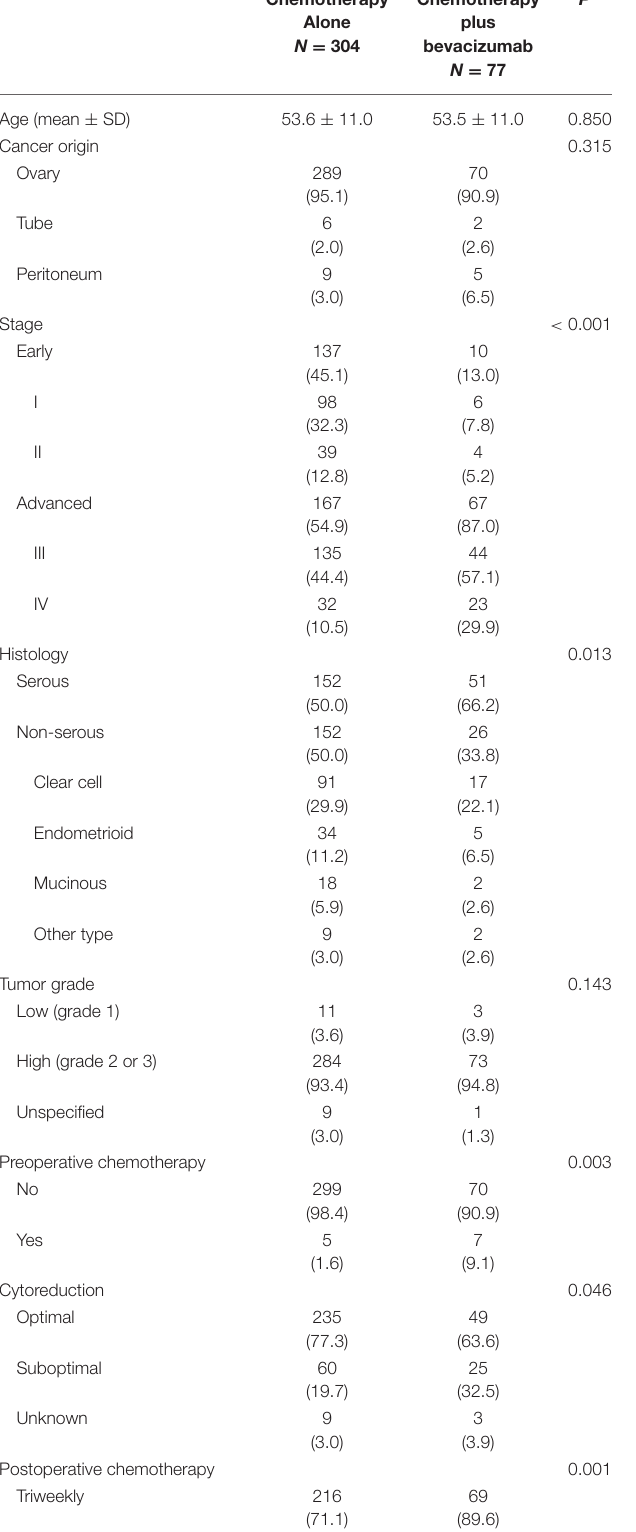
TABLE 1 | Clinico-pathological characteristics of newly diagnosed patients (Cohort 1) ( N = 381).